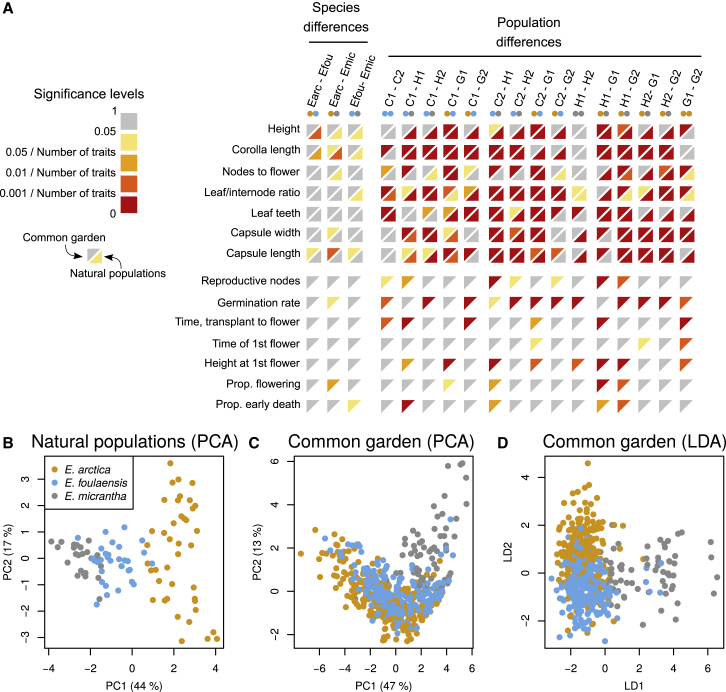
Morphological Trait Differentiation between Three Species of Euphrasia in a Common Garden Experiment and in Natural Populations.(A) Significance levels of trait differences between species (left) and populations (right) from field measurements in natural populations (bottom right triangles) and in the common garden (top left triangles, see Supplemental Text 1 for the magnitudes of differences and Supplemental Table 2 for the means and standard errors). Comparisons within rows are corrected for multiple testing. Within columns, the color scale is the p value corrected for the number of traits tested (seven in natural populations and 14 in the common garden). While significant trait differences are rare between species, they are numerous between populations (see Figure 1A or Supplemental Table 1 for population codes).(B) PCA of trait measurements from natural populations shows separate clusters per species.(C) PCA of trait measurements from plants grown in the common garden shows little grouping by species.(D) LDA separates species in the common garden.